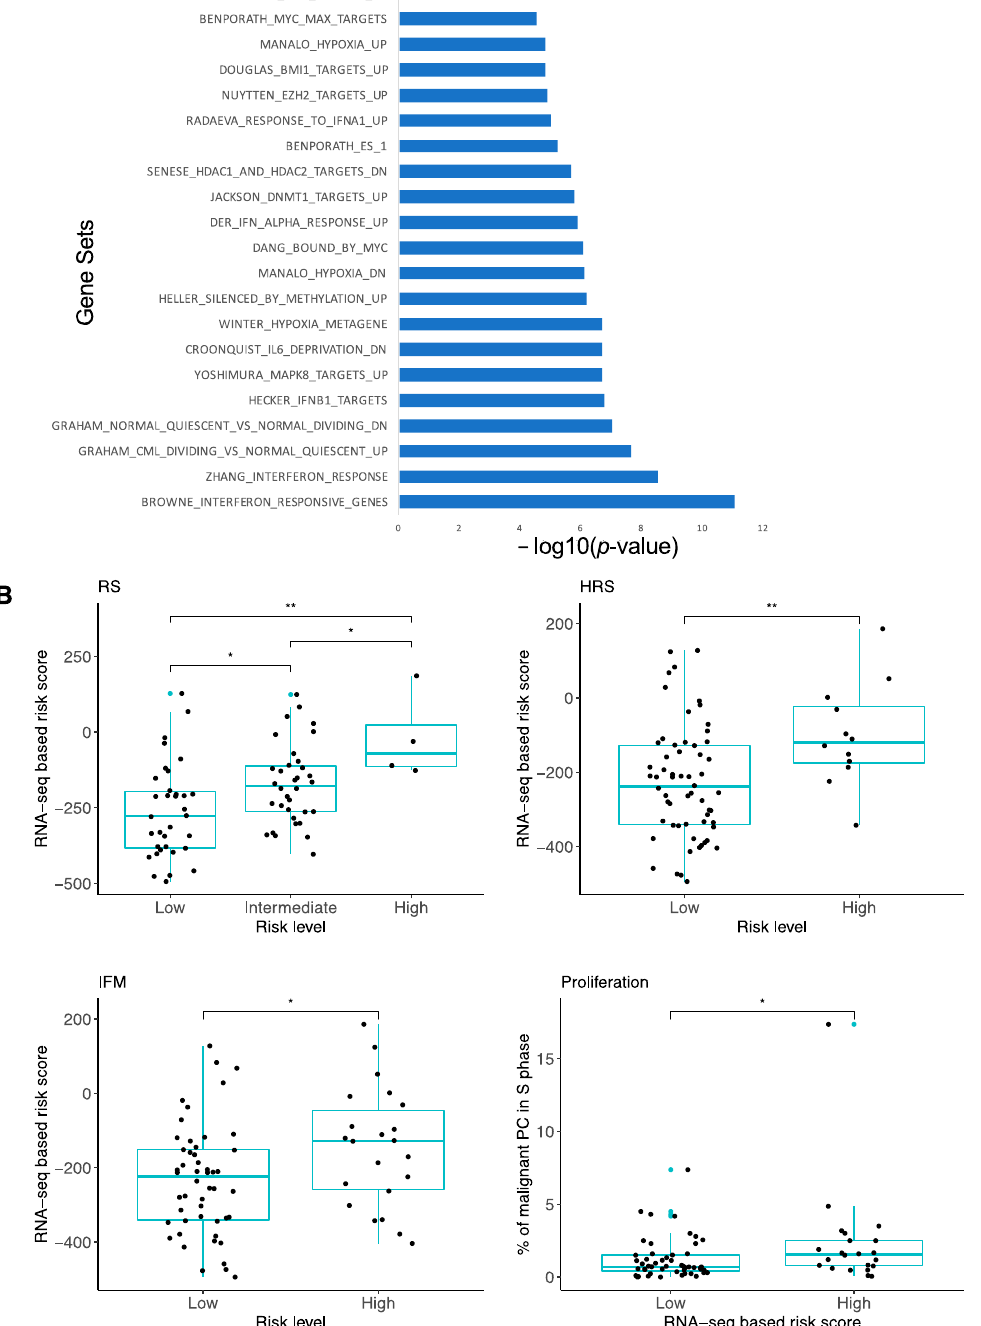
Figure 2. Characterization of RNA-seq-based risk score. ( A ) Gene set enrichment analysis of RNA-seq-based risk score genes associated with poor prognosis. DN: downregulated; UP: upregulated. A complete description of all of the molecular signatures presented is available in the GSEA molecular signatures database (https://www.gsea-msigdb.org/gsea/msigdb/ index.jsp) (28 September 2021). ( B ) Comparison of RNA-seq-based risk score with Affymetrix GEP-based risk scores (RS, HRS, IFM) and proliferation. Wilcoxon test. ns: nonsignificant, * p -value < 0.05, ** p -value <